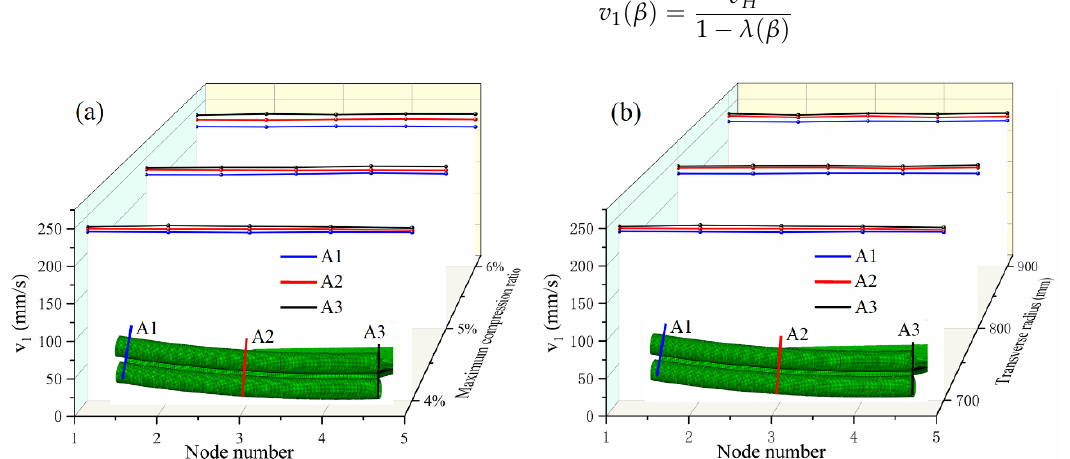
Figure 4. Longitudinal exit velocity of the nodes on the normal line of sheet metal: ( a ) Under the condition of different maximum compression ratios; ( b ) Under the condition of different transverse radii.